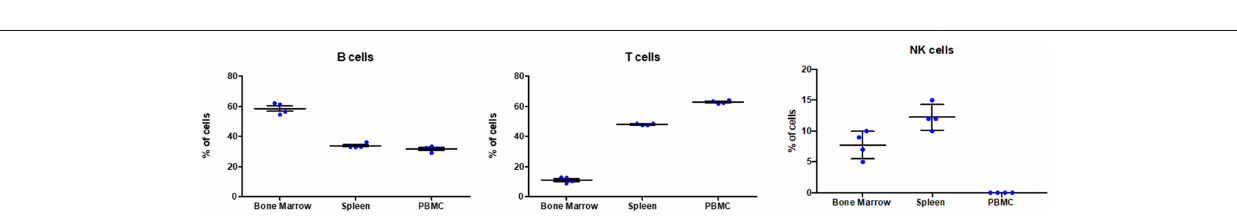
TABLE 3 | Comparison of B and T cell percentages in bat, murine and human tissues.